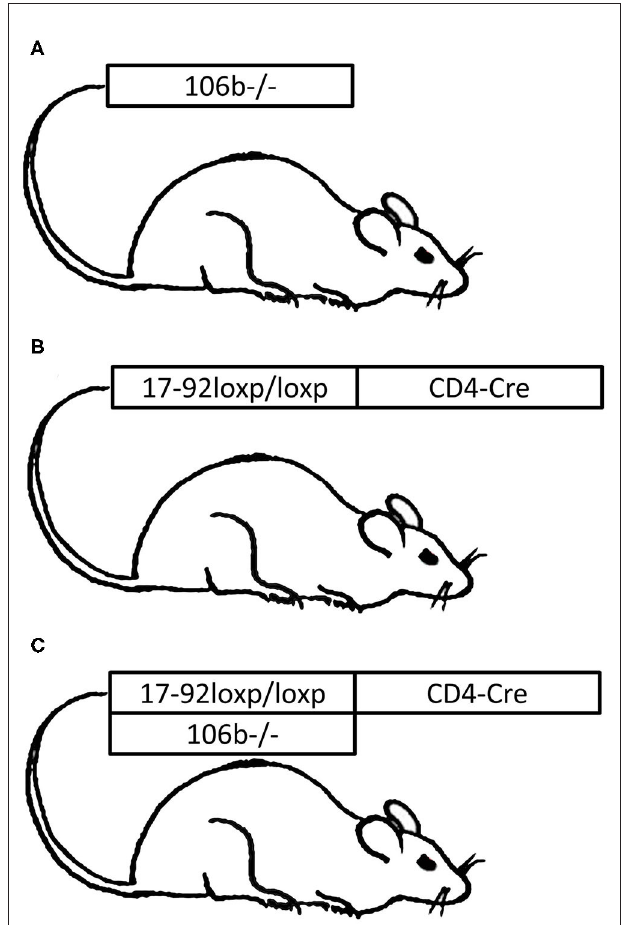
FIGURE 1 | Graphic representation of the three mutant strains used for the EAE experiments. Experimental Autoimmune Encephalomyelitis (EAE) was induced in mice constitutively deleted for (A) miR106b-25 cluster (106b − / − mouse), (B) miR17-92 in CD4 + T cells (17-92 − / − mouse), or in mice with (C) both mutations (106b − / − 17-92 − / − mouse). miR17-92 was conditionally deleted only in CD4 + T cells because mice deficient for miR-17-92 die shortly after birth ( 10).